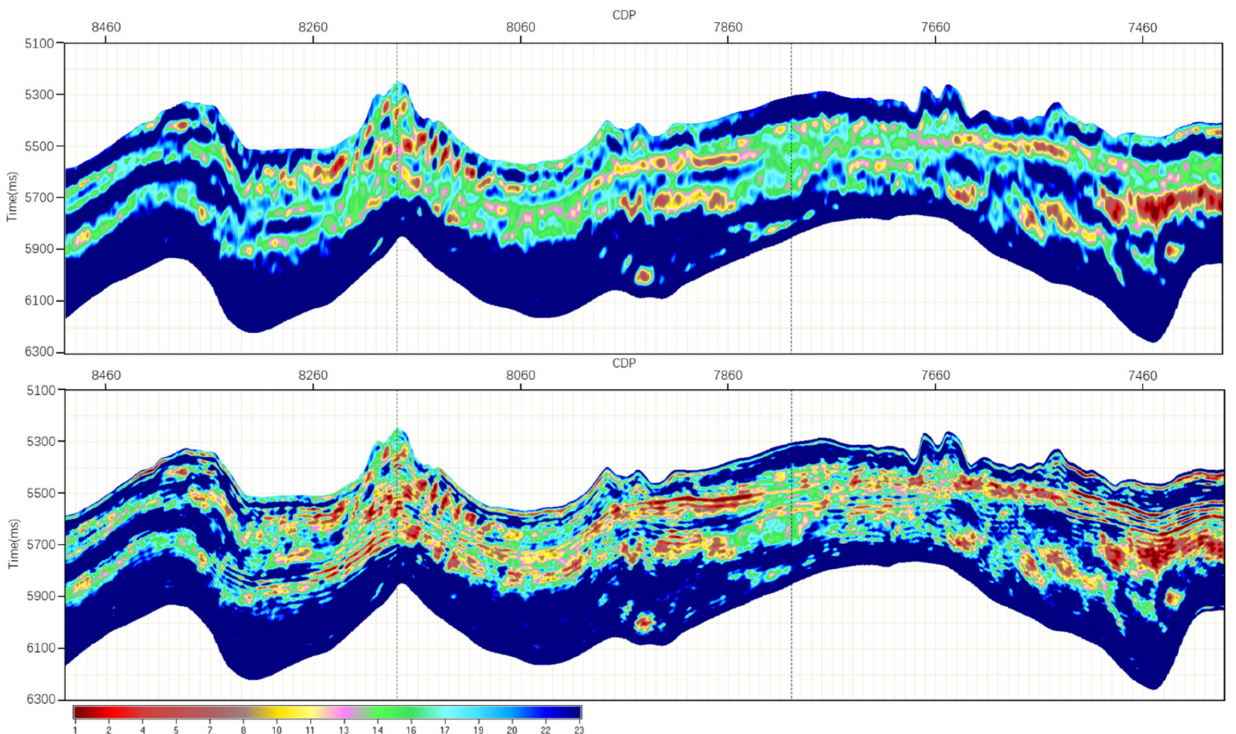
Figure 8. Comparison results of the constrained sparse spike inversion and the multiparameter joint inversion of the Lame coefficient profile. The upper figure is the constrained sparse spike inversion result, and the lower figure is the multiparameter joint inversion